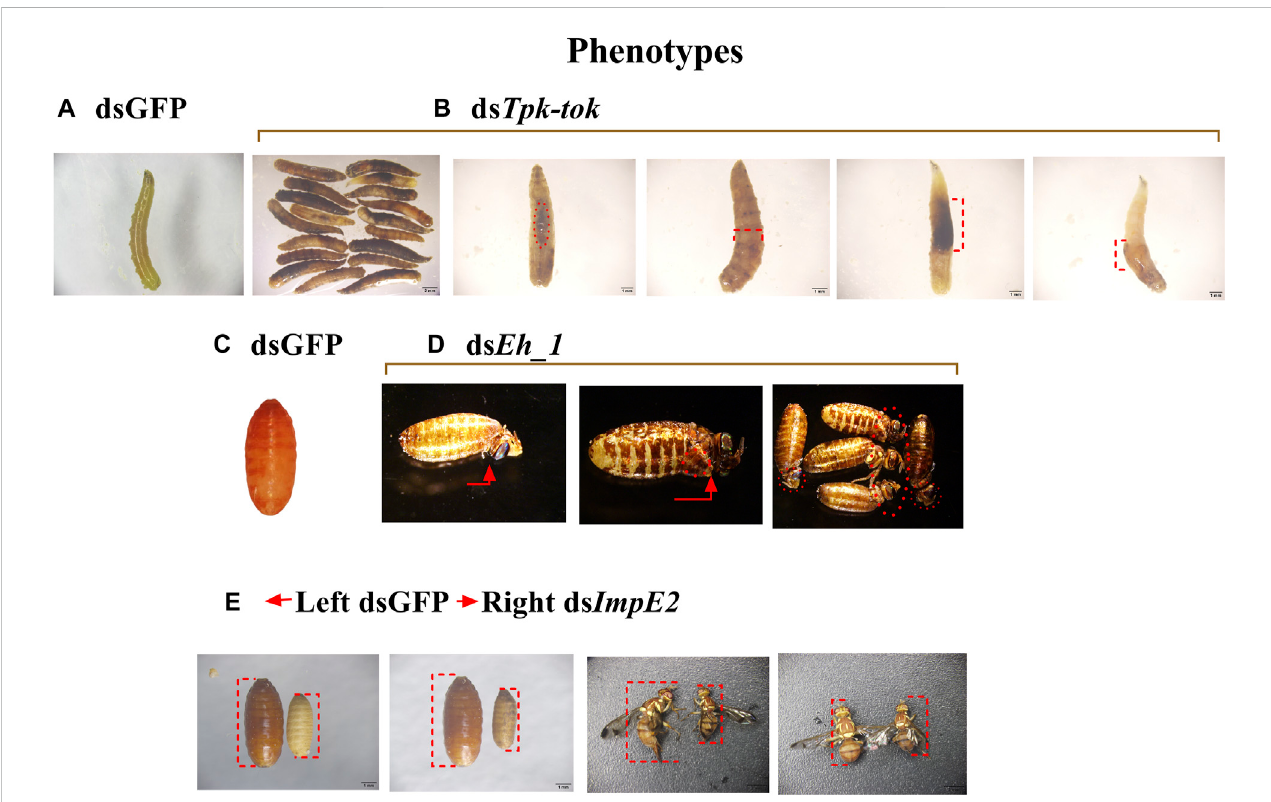
FIGURE 4 Developmental defects observed in Z. cucurbitae fl ies after the knockdown of (B) Tpk-tok , (D) Eh_1 and (E) ImpE2 genes. (A) 3rd instar of Z. cucurbitae after feeding on dsGFP-enriched food (control fl ies). (C) Normal pupae from the dsGFP control treatment. Red lines and circles represent the insect body ’ s damage, blockage, and swell portion in (B) and reduced body size in (E) , while red arrows show the old insect cuticle still attached to their body in (D)